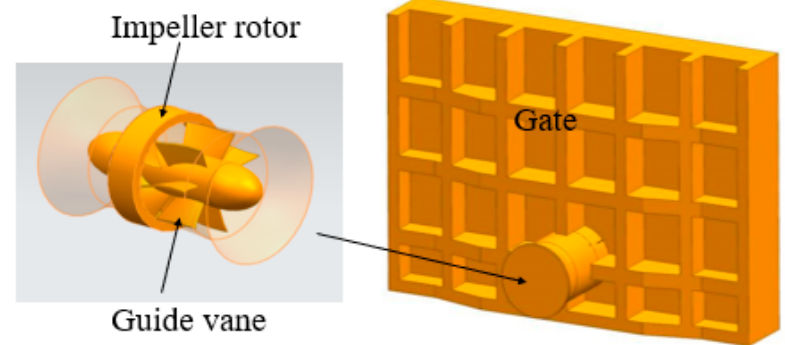
Figure 3. Calculation model of the integrated pump gate full flow channel.